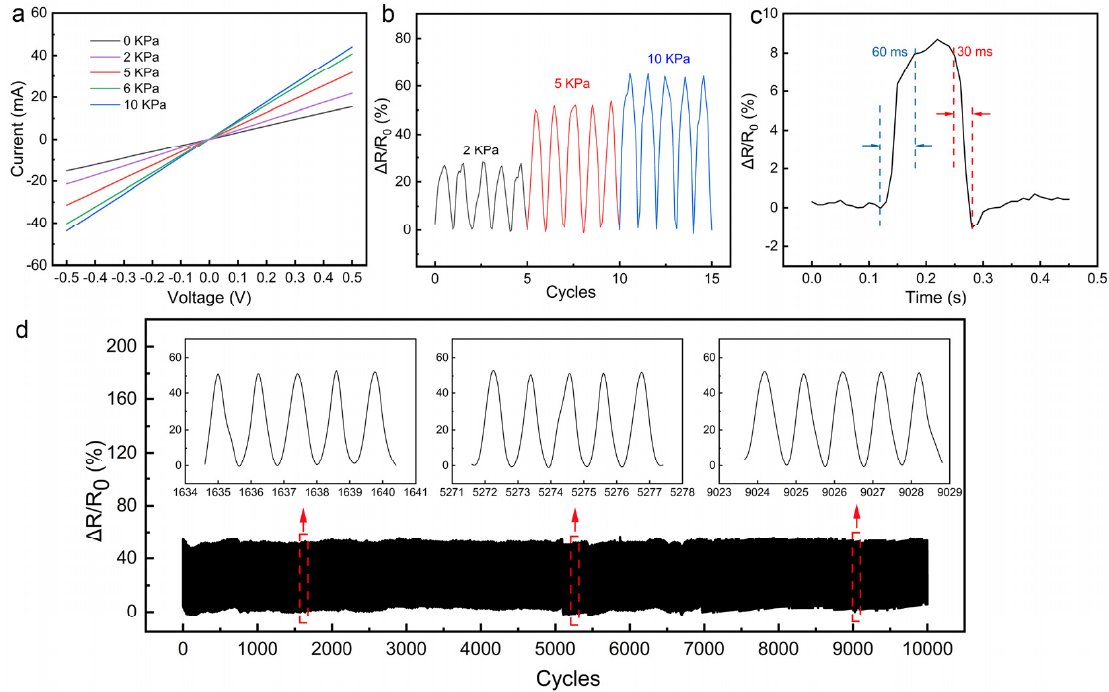
Figure 5. ( a ) I–V curves of the fabricated piezoresistive pressure sensor under different pressures; ( b ) relative resistance changes of the pressure sensor versus cyclic loading of 2 kPa, 5 kPa, and 10 kPa; ( c ) response and recovery time of the pressure sensor under a gentle touch; ( d ) cycling stability of the as-prepared sensor over 10,000 cycles under 5 kPa.